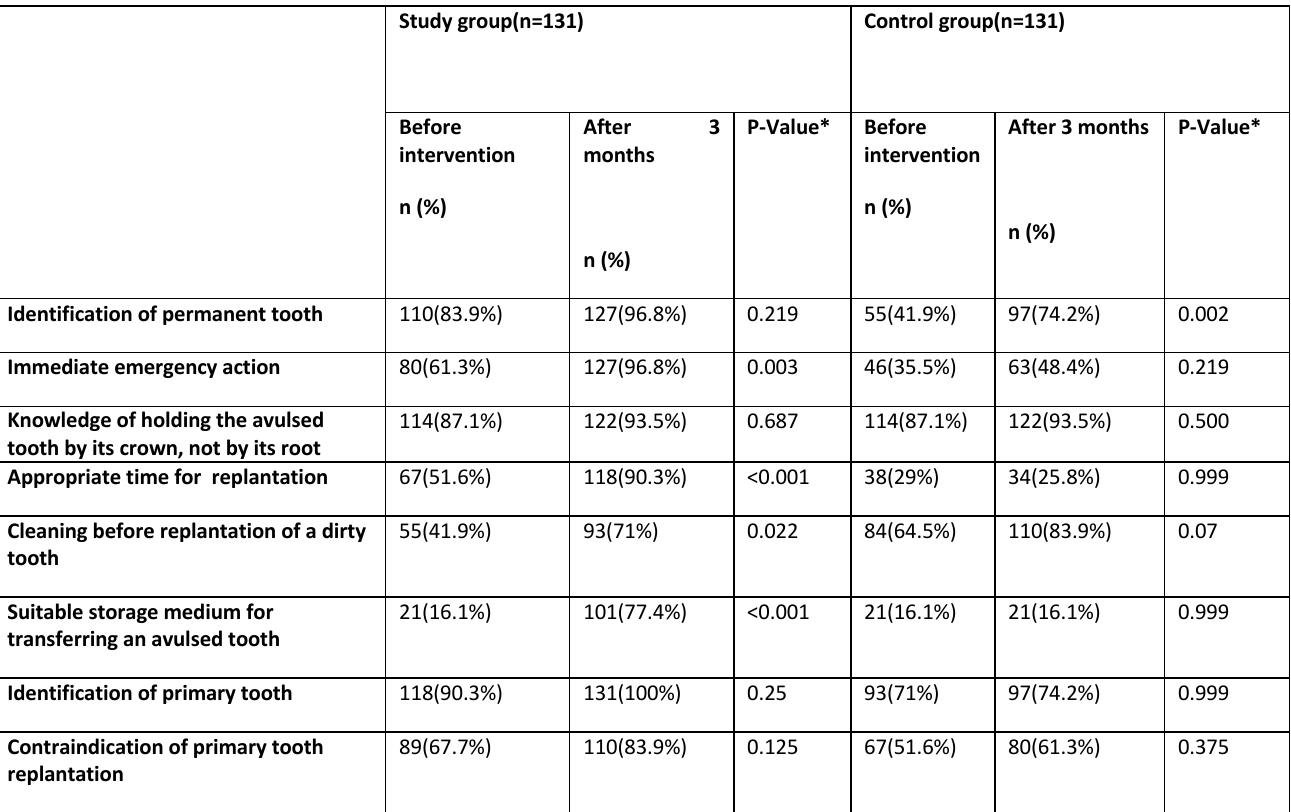
*P-value was based on McNemar Test